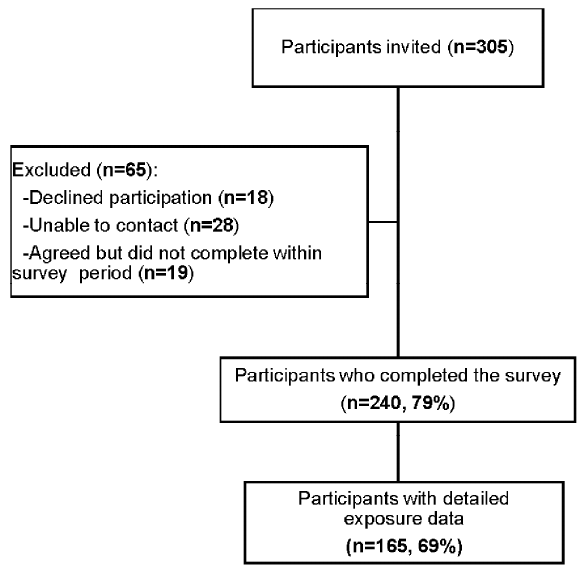
Figure 1. Participant flow diagram.